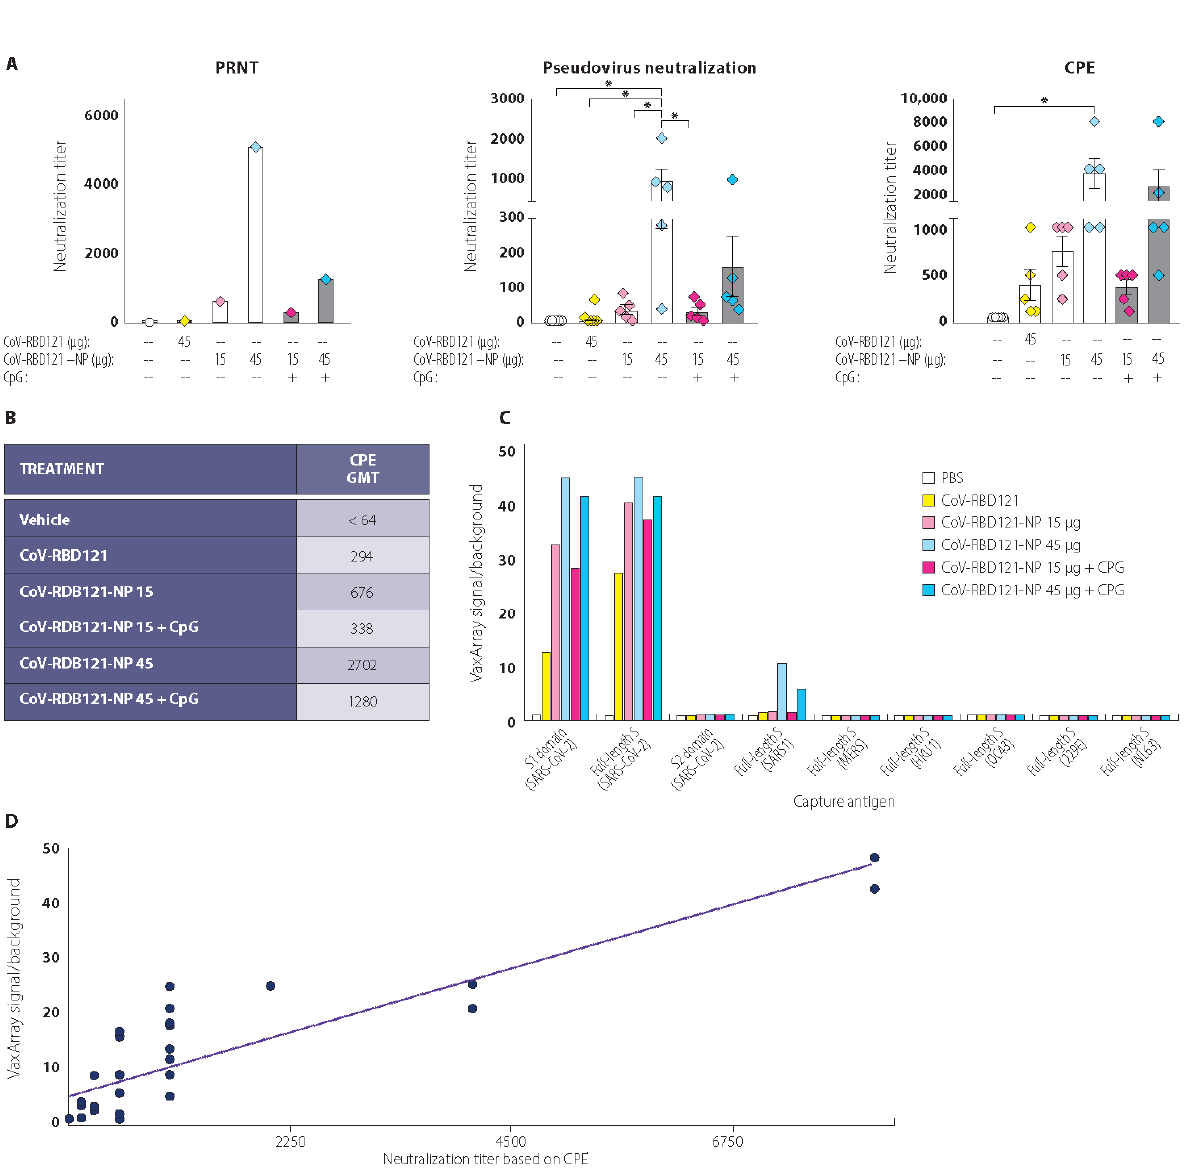
Figure 5. Induction of neutralizing antibodies and antibody specificity by CoV-RBD121 or CoV-RBD121-NP. ( A ) Neutralizing activity of the antibodies in the mice was evaluated in sera collected on day 42. For the PRNT assay, sera were pooled because quantities were limiting. For the pseudovirus neutralization assay or CPE assay, results for each mouse are shown. Significant differences among the groups were determined by one-way ANOVA with Tukey’s correction for multiple comparisons ( n = 4–5 mice per group; * p ≤ 0.05). ( B ) CPE data were used to calculate a GMT for each group. ( C ) Specificity of the antibody response was evaluated by VaxArray SeroAssay. Results from day 42 pooled sera. Data are presented as the ratio of signal to background. ( D ) Correlation analysis for neutralization titer for each mouse based on CPE results and VaxArray results for S1. Results of linear regression analysis and R 2 are provided. Significant differences among the groups were determined by one-way ANOVA with Tukey’s correction for multiple comparisons ( n = 4–5 mice per group as indicated; * p ≤ 0.05). Colors are coordinated to indicate individual values for mice immunized with PBS (clear); CoV-RBD121 antigen alone (yellow); 15 mcg CoV-RBD121-NP (magenta); and 45 mcg CoV-RBD121-NP (blue) at day zero (circles), Day 12 post vaccination (squares), Day 28 post vaccination (triangles) and Day 42 post vaccination (diamonds).